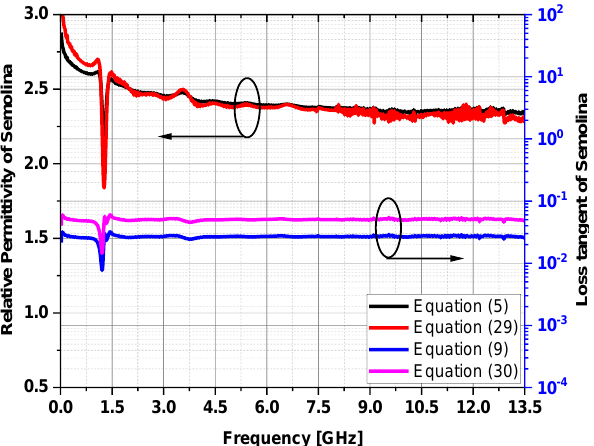
Figure 7. Relative permittivity and loss tangent of the semolina measured with the circular coaxial test cell.